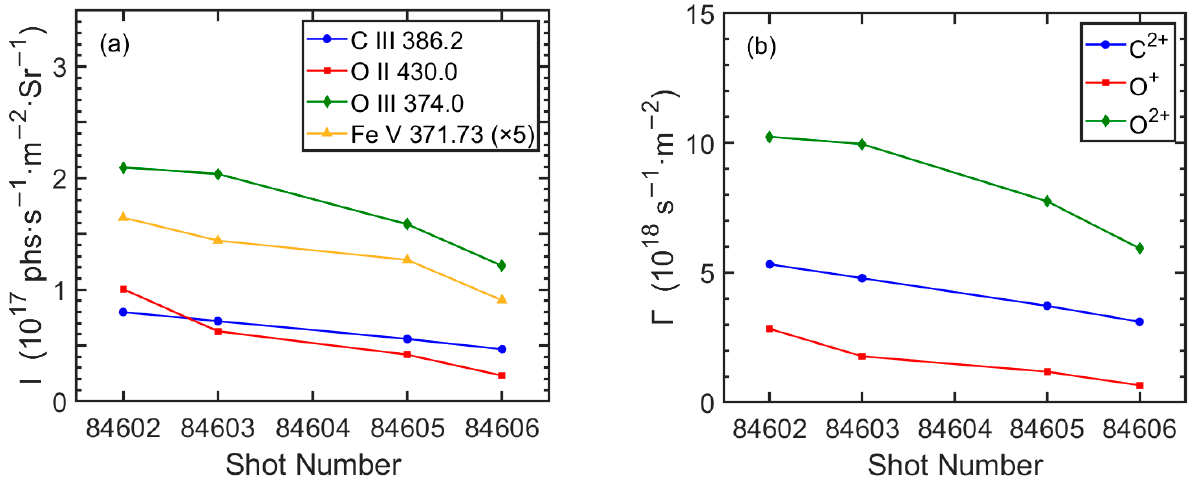
Figure 11. ( a ) Intensity of impurity lines of C III 386.2 Å (blue), O II 430.0 Å (red), O III 374.0 Å (green), and Fe V 371.73 Å (orange) and ( b ) particle influx of C 2+ (blue), O + (red), and O 2+ (green) at I p platform phase (t = 5.0 s) changes in several successive discharges with real ‐ time lithium granule injection, in which the particle influxes are calculated from line intensity of and the S/XB data at certain T e and n e , respectively.